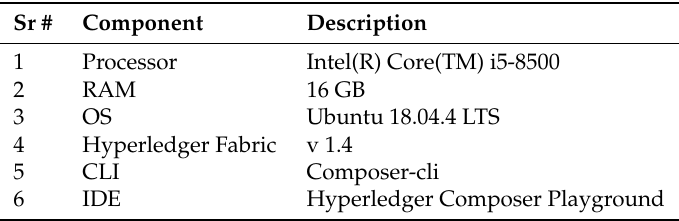
Table 2. CCTV-blockchain simulation